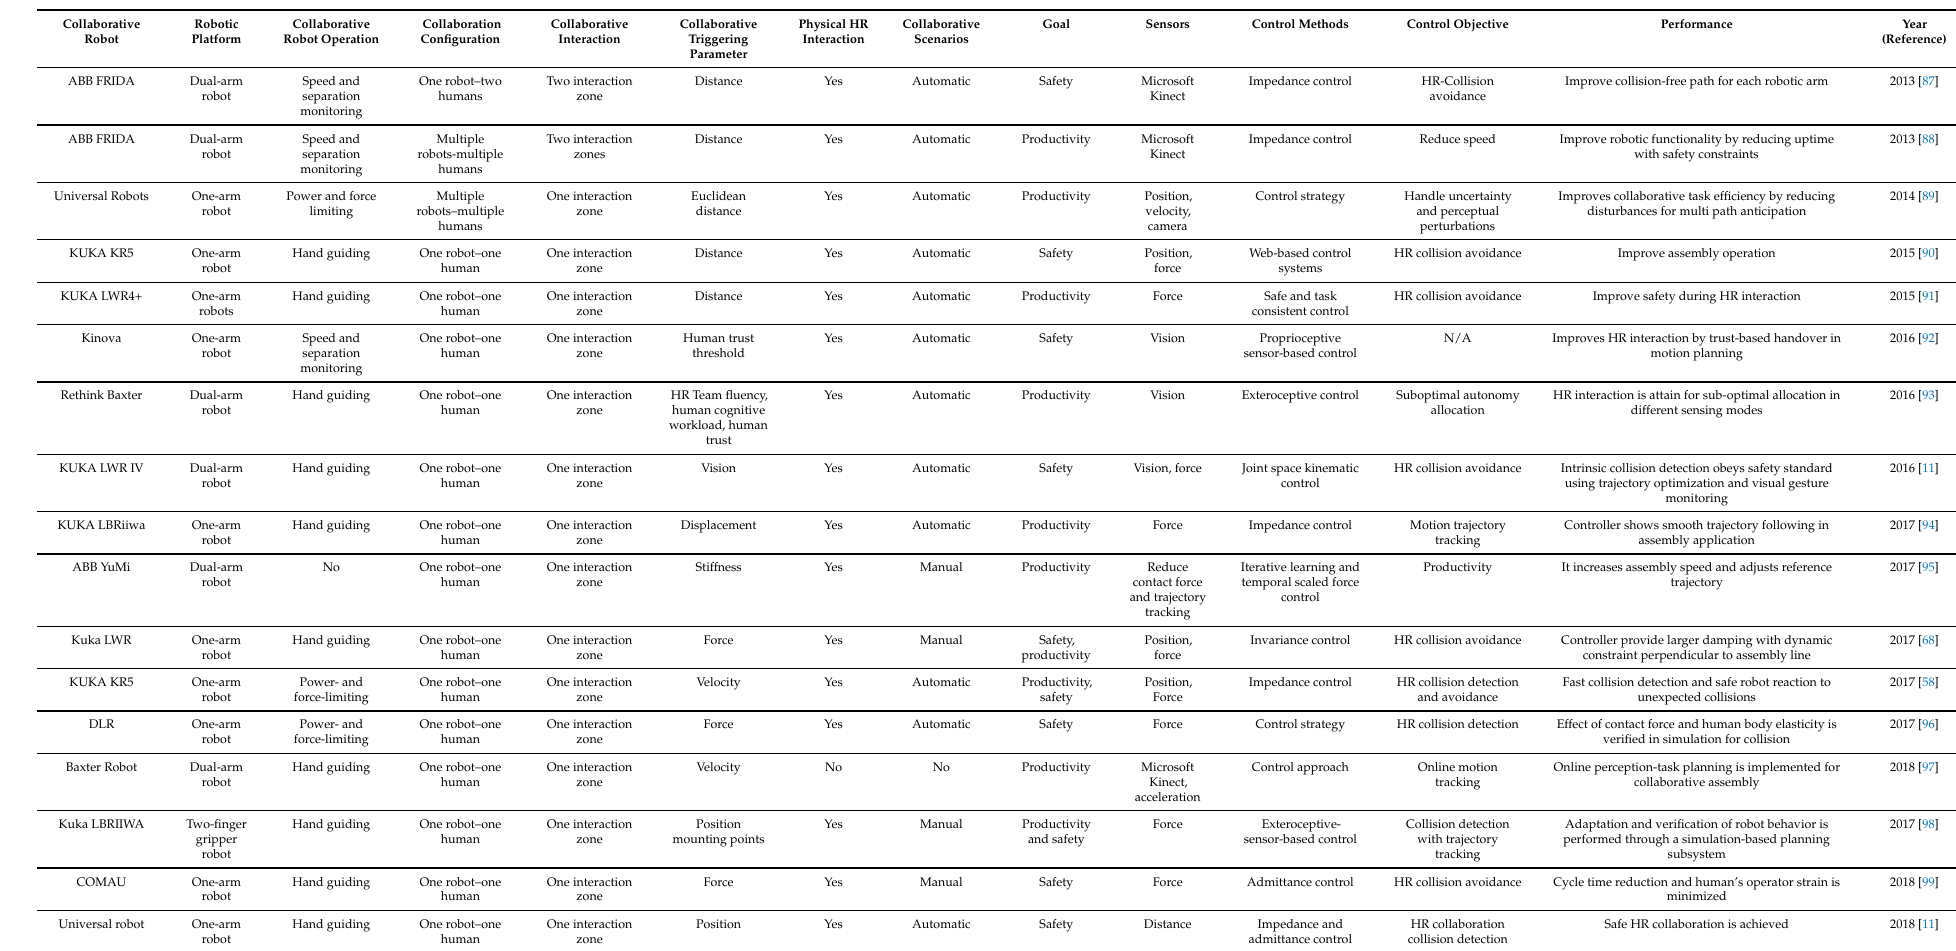
Table 2. Comparison of control methods applied to collaborative robots in HR-collaborative assembly